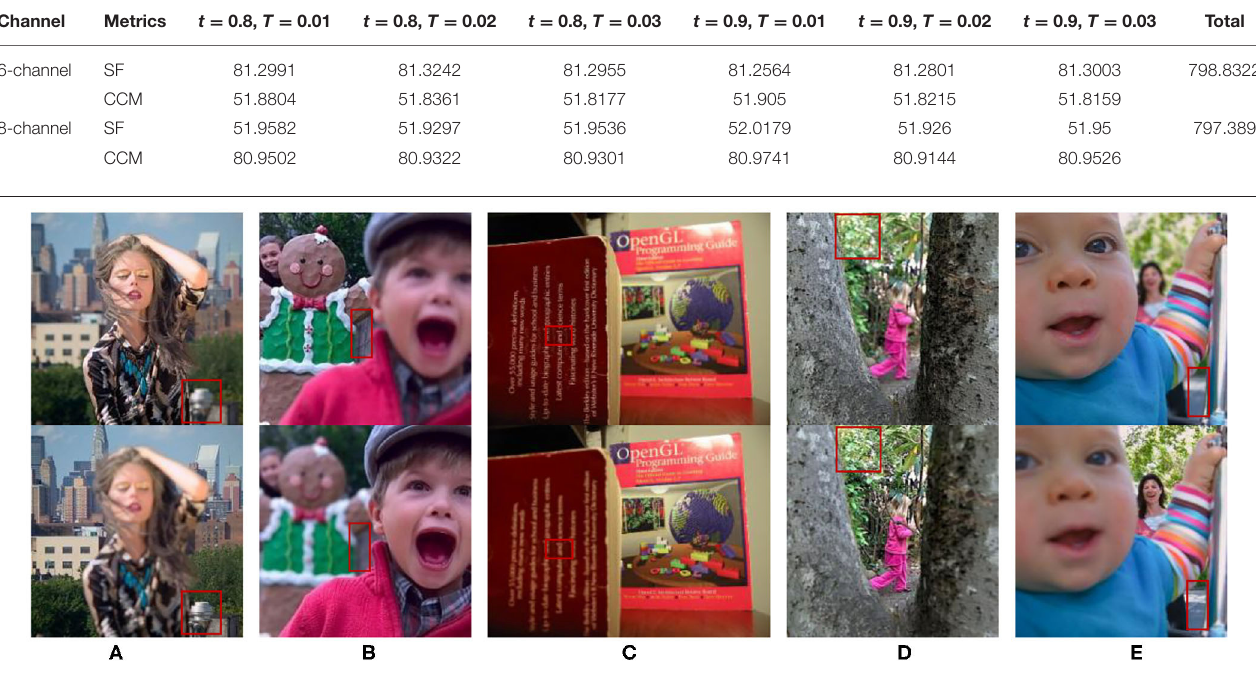
FIGURE 4 | Five groups of multi-focus color original images. Red frames are the area that need to be compared in image fusion. (A) Woman, (B) Child, (C) Book, (D) Girl, and (E) Baby. The four images (A,B,D,E) from Lytro dataset, the image (C) from Saeedi